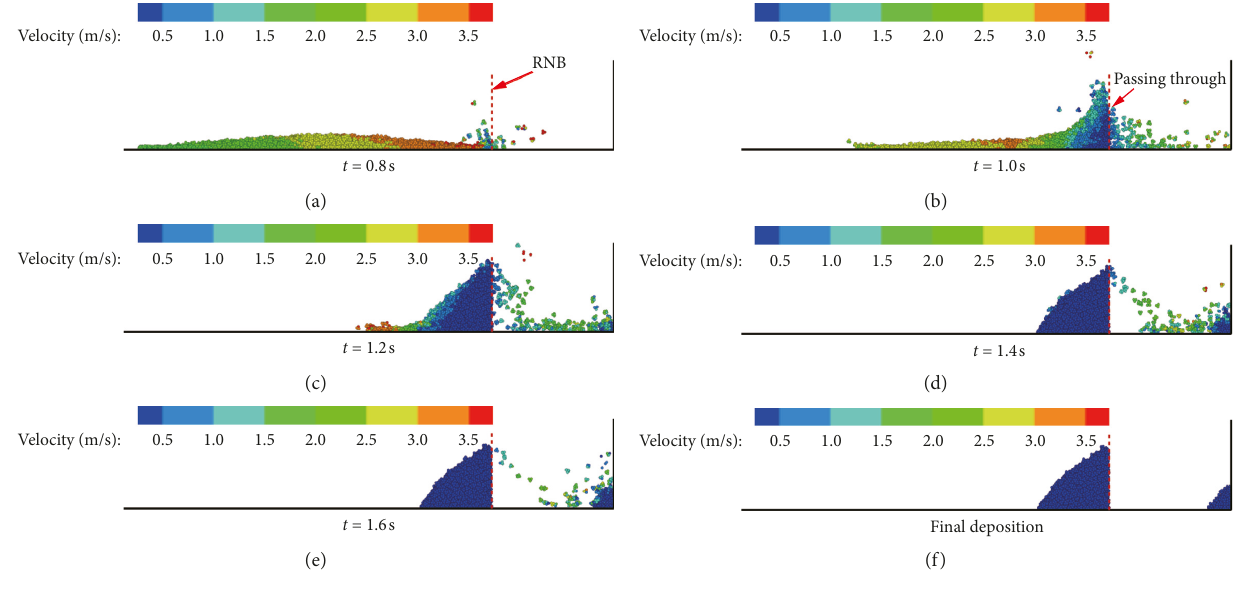
Figure 16: Granular flow process in Case C3.